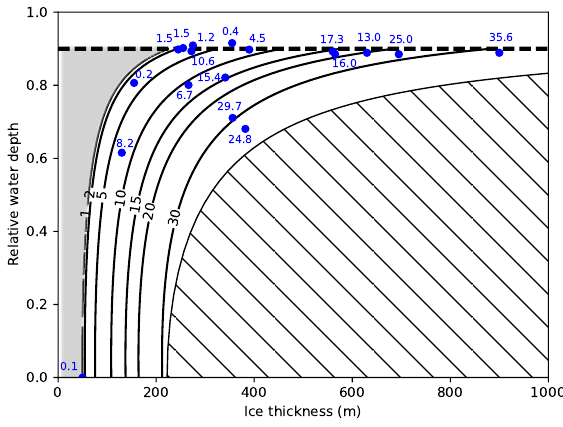
Figure 13. Calving rates (md − 1 ) predicted by the parametrization are shown as contours in dependence of H and ω . The hatched re- gion indicates the states excluded by the maximum calving front criterion (Bassis and Walker, 2012). The gray area indicates states where the stress threshold σ th precludes calving. Blue dots with numbers indicate calving rates determined from measurements, shown in Table